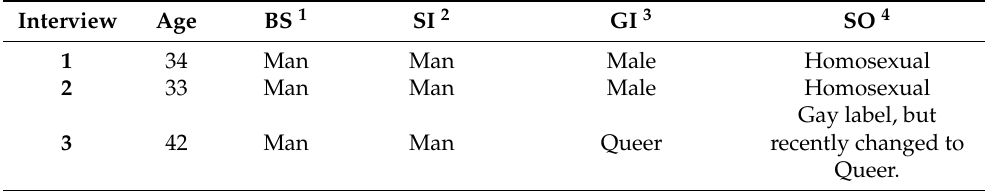
Table 1. Sexuality and Gender: individuals’